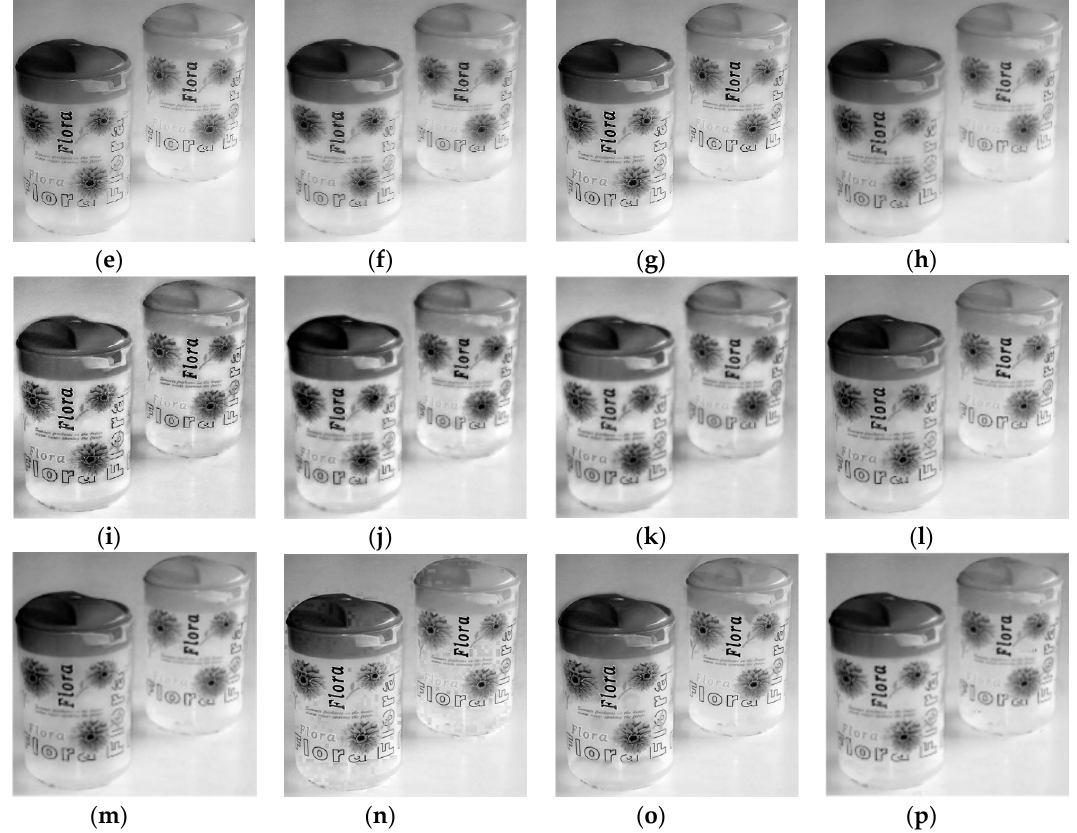
Figure 8. Fused images obtained by different methods in the image pair “flora”. ( a ) PCA; ( b ) SWPCA;